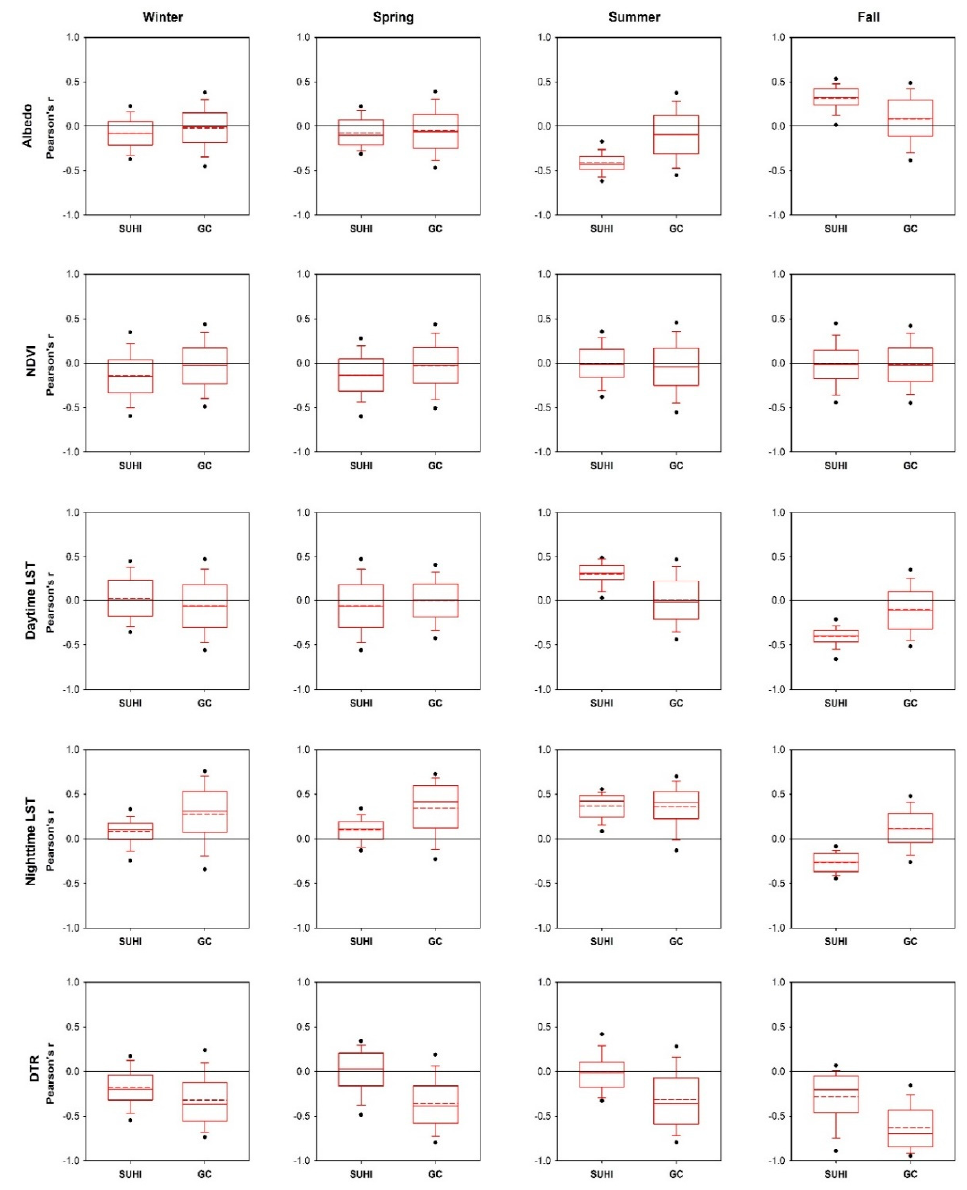
Figure 9. Pearson’s correlation coe ffi cient calculated between the detrended nighttime LST anomaly and a variety of driving forces between 2003 and 2019. Results are presented for the SUHI area, as compared to other parts of Greater Cairo